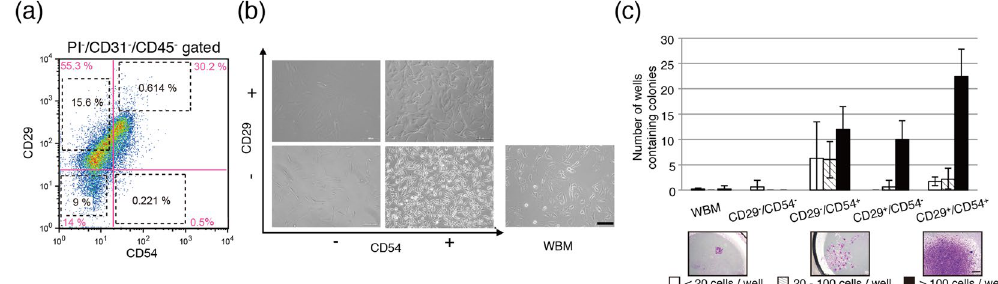
Figure 1. Morphological and self-renewal evaluation by clonal analysis. ( a ) Representative flow cytometric profiles of rBM cells stained for CD29 and CD54. PI − , CD45 − , and CD31 − cells were gated. Baseline CD29 and CD54 expression is shown in pink. Sorted subsets are shown in black dotted squares. The cell number ratio is shown in the profile. ( b ) Morphological appearance of sorted sub-population cells. Scale bar, 100 µ m. ( c ) Single- cell sorting assay of rBM cell sub-populations. WBM cells and four cell populations (CD29 + /CD54 + , CD29 + / CD54 − , CD29 − /CD54 + , and CD29 − /CD54 − ) were sorted into 96-well plates, and the number of colonies formed was counted on day 10. Scale bar, 500 µ